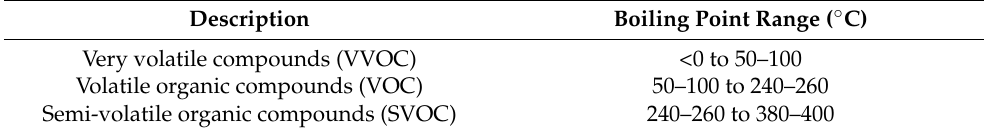
Table 1. Classification of VOCs according to boiling